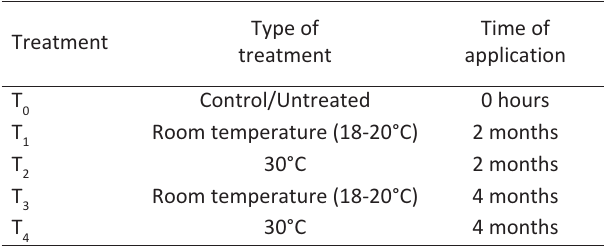
Table 1 ­ Different heat treatments used to enhance seed ger­ mination of Cycas